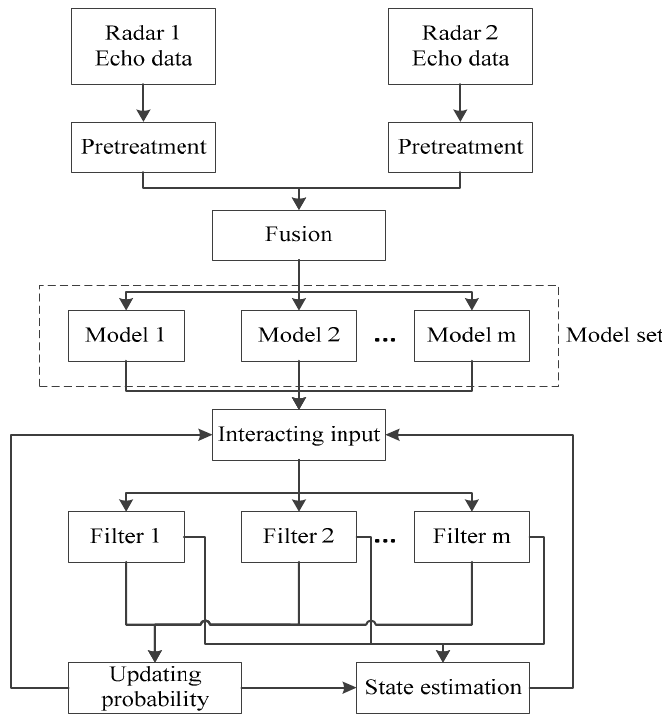
Figure 1. Schematic diagram of the stereoscopic High frequency surface wave radar (HFSWR) system.